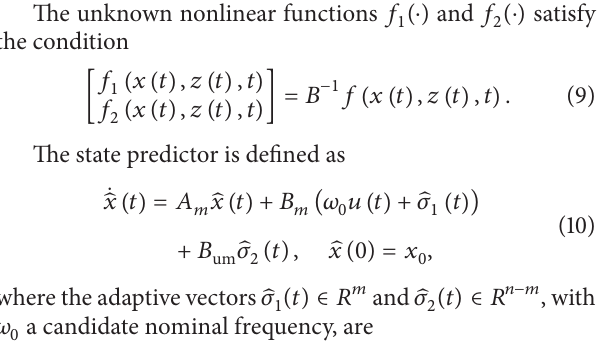
includes 𝜔 ∈ 𝑅 𝑚×𝑚 the unknown frequency gain matrix, 𝑧(𝑡) and 𝑥 𝑧 (𝑡) , respectively, the output and state vector of internal unmodeled dynamics and the unknown nonlinear functions (⋅) 𝑔(⋅) and 𝑔 0